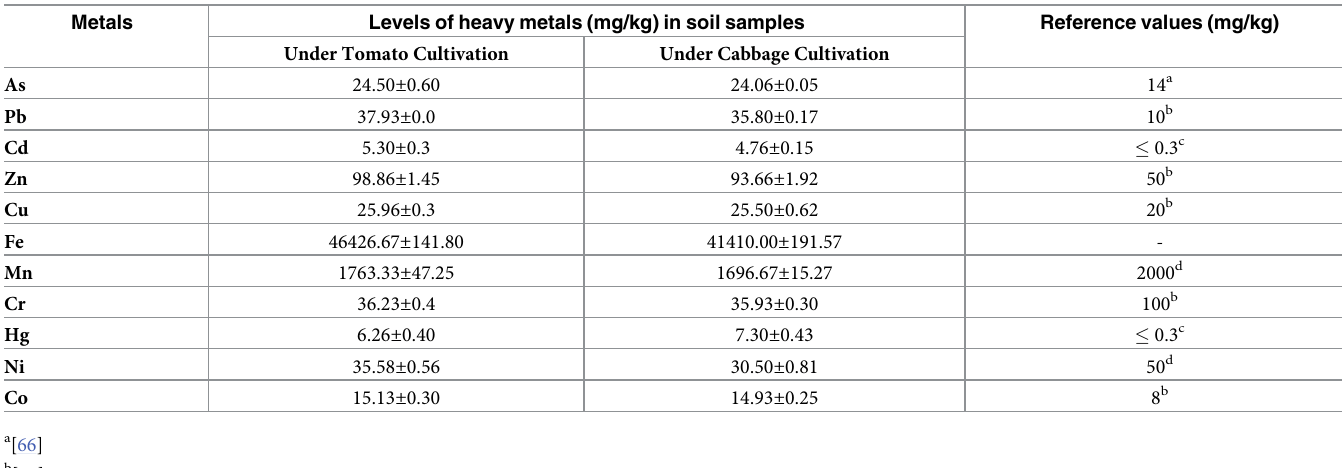
Table 3. Levels of heavy metals (mg/kg) in soil samples collected from Mojo area farmlands in central Ethiopia.